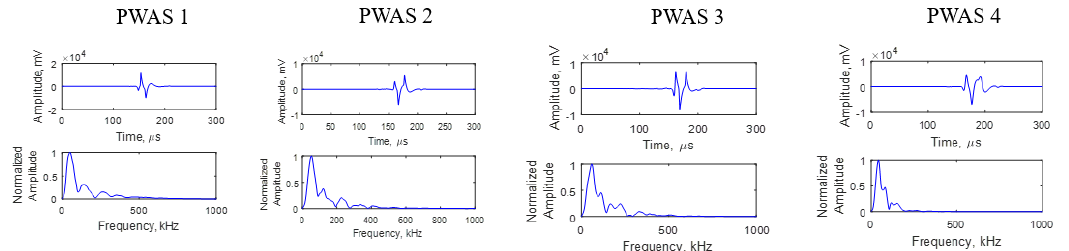
Figure 12. Signal correspondence at all four PWAS due to the 1st impact hit.